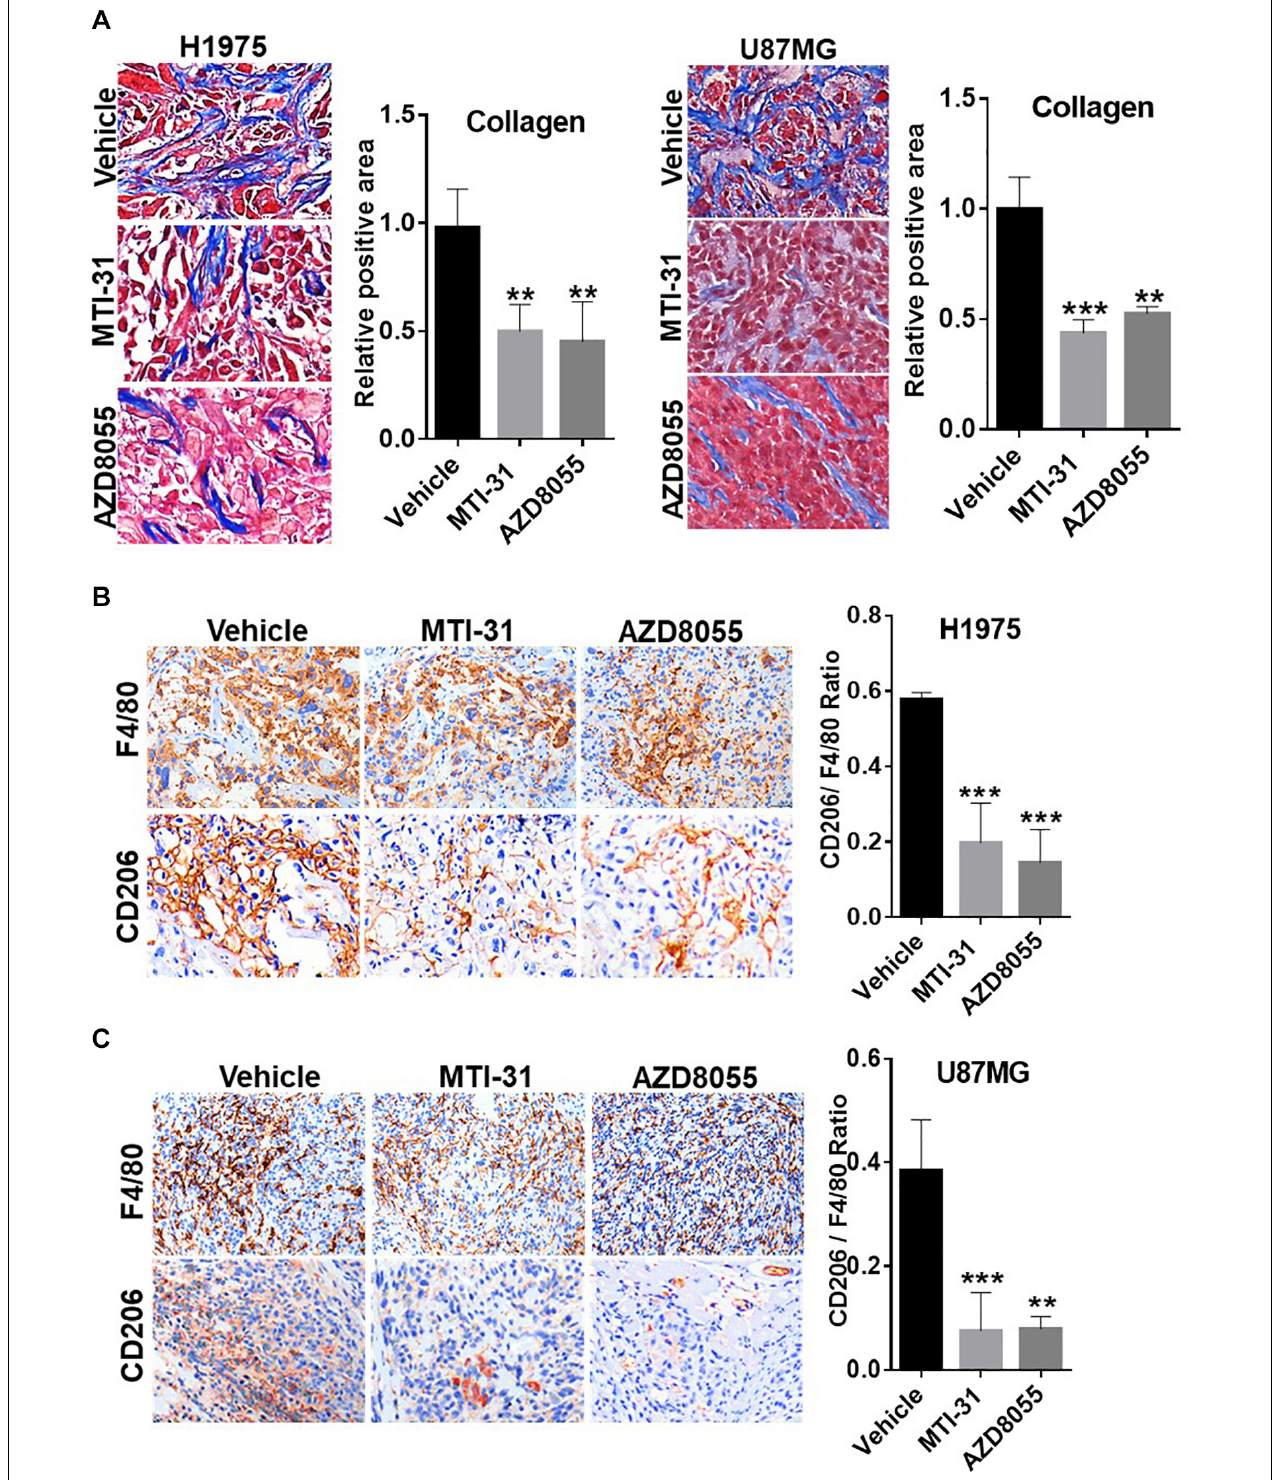
FIGURE 5 | Involvement of mTOR-TF axis in tumor microenvironment. (A) H1975 and U87MG tumor sections as described in Figure 4 were subjected to Masson’s trichrome staining as described in section “Materials and Methods.” (B,C) Tumor sections as in (A) were analyzed for TAM infiltration by IHC staining with anti-F4/80 and anti-CD206 as described in section “Materials and Methods.” The calculated the ratio of CD206 versus F4/80 indicates the levels of M2-type TAMs. For (A–C) , representative images are shown (left panels) and quantified (right panels). ** P < 0.01, *** P < 0.001.